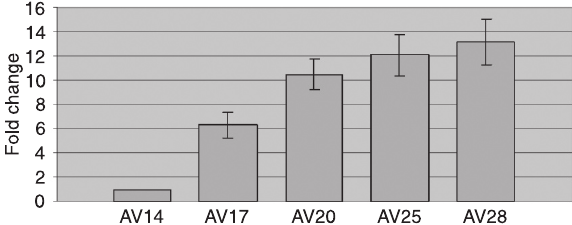
Figure 5. Relative quantitation of β2 integrin expression in the chicken atrioventricular (AV) canal. mRNA was isolated from dis- sected AV canals at different stages of development and ana- lyzed using real-time PCR. β2 integrin mRNA was detectable at stage HH14, increased significantly at HH17, during the period when numerous mesenchymal cells are actively migrating in the endocardial cushions, and progressively increased in subsequent stages. mRNA fold changes were calculated relative to the values obtained for HH14. Data are reported as means ± SEM for three experiments.